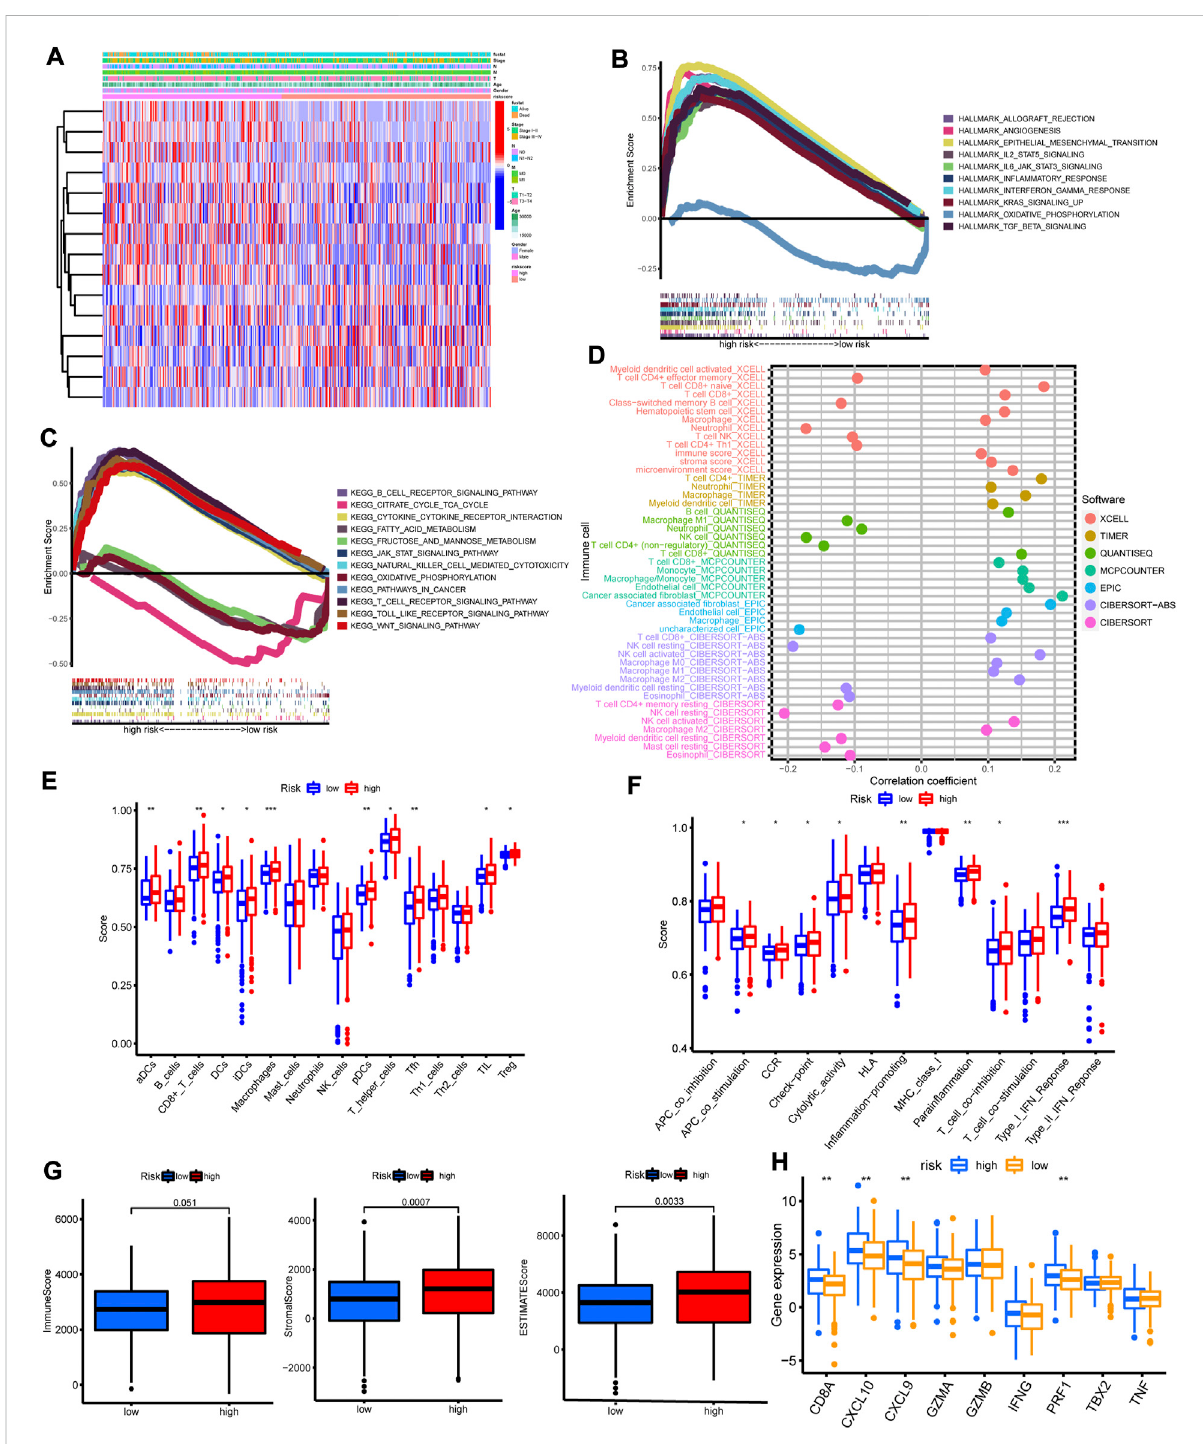
FIGURE 5 The correlations between clinicopathological features and immune cell in fi ltration with risk score. (A) The heatmap of 15 model lncRNAs expression and clinicopathological features in high and low risk group. (B) The heatmap of GSVA with hallmark sets between high and low risk group. (C) TheheatmapofGSVAwithKEGGsetsbetweenhighandlowriskgroup. (D) Theimmunecellbubbleplot. (E,F) Theenrichmentofimmune cells and immune functions in high and low risk group by ssGSVA algorithm. (G) The immune score, stromal score and ESTIMATE score in high and low risk group by ESTIMATE algorithm. (H) The expression of immune activated genes between high and low risk group. * p < 0.05; ** p < 0.01; *** p <